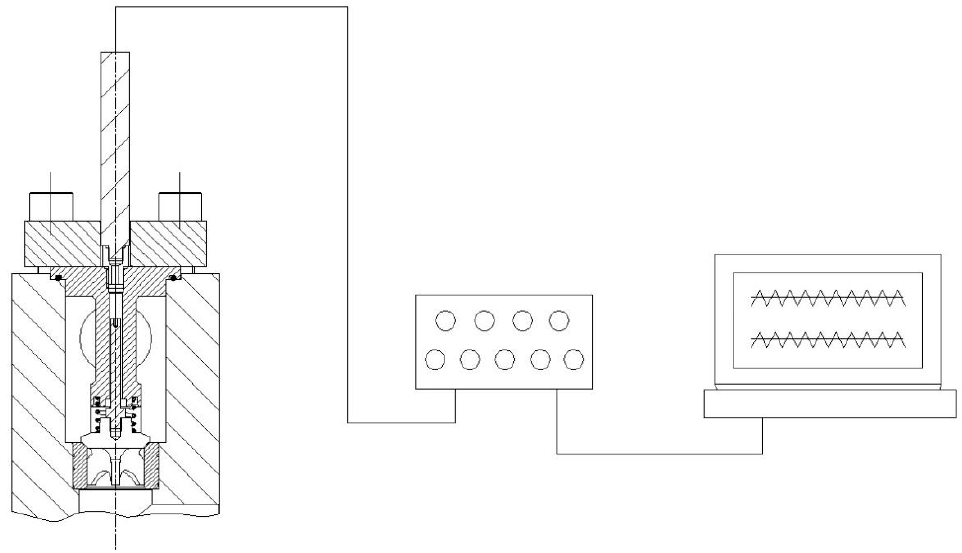
Figure 2. Schematic of the pump valve motion testing system.